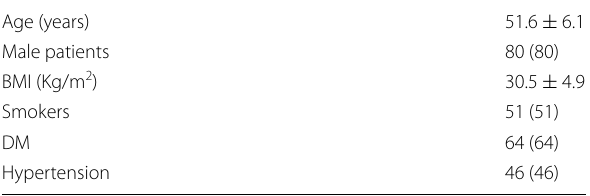
Table 1 Baseline demographic characteristics of all